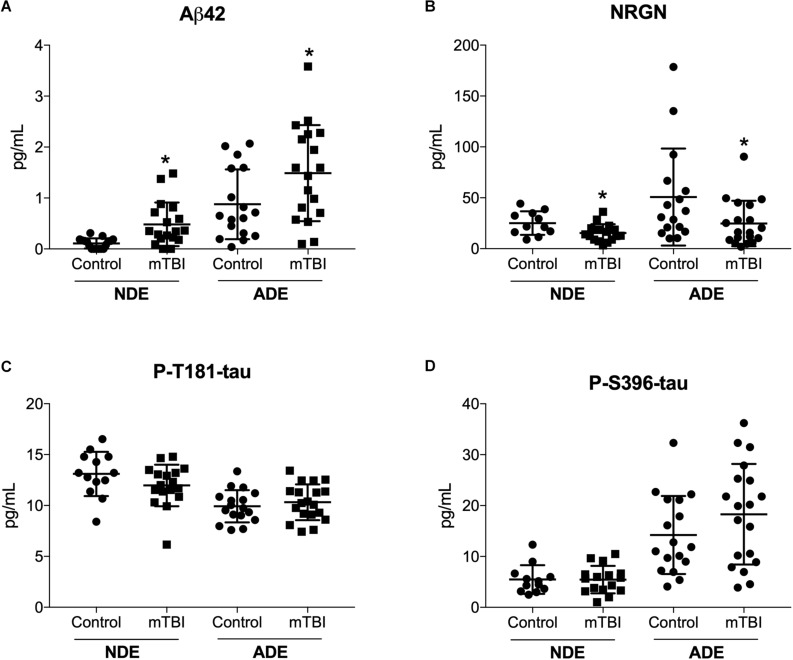
Human plasma NDE and ADE levels Aβ1–42 and NRGN differentiate young mTBI individuals from individuals with no TBI history. Plasma NDE and ADE (A) concentrations of Aβ42 were significantly higher, whereas plasma NDE and ADE (B) concentrations of NRGN were significantly lower in young individuals with mTBI (n = 17) compared to age-matched controls (n = 20). Plasma NDE and ADE concentrations of P-T181-tau (C), and P-S396-tau (D) were not significantly different between the two groups. Non-parametric t-test, ∗P < 0.05 vs. control.